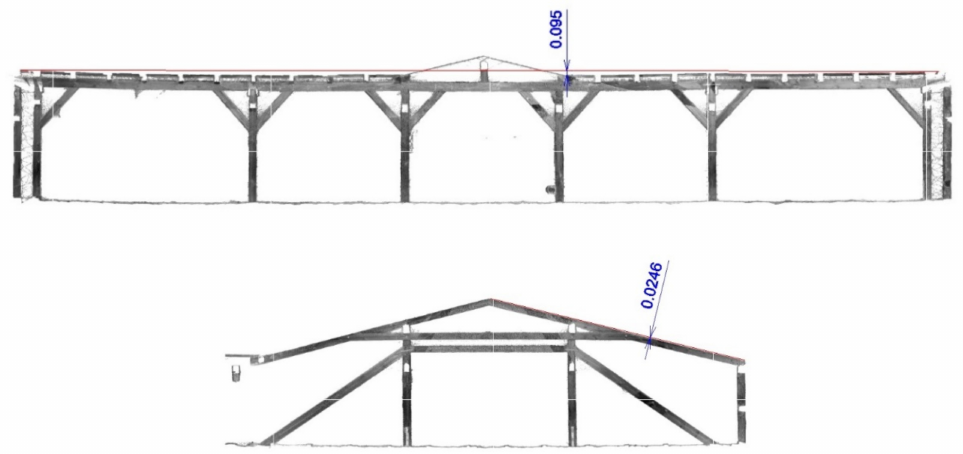
Figure 16. Section through the roof with deflection